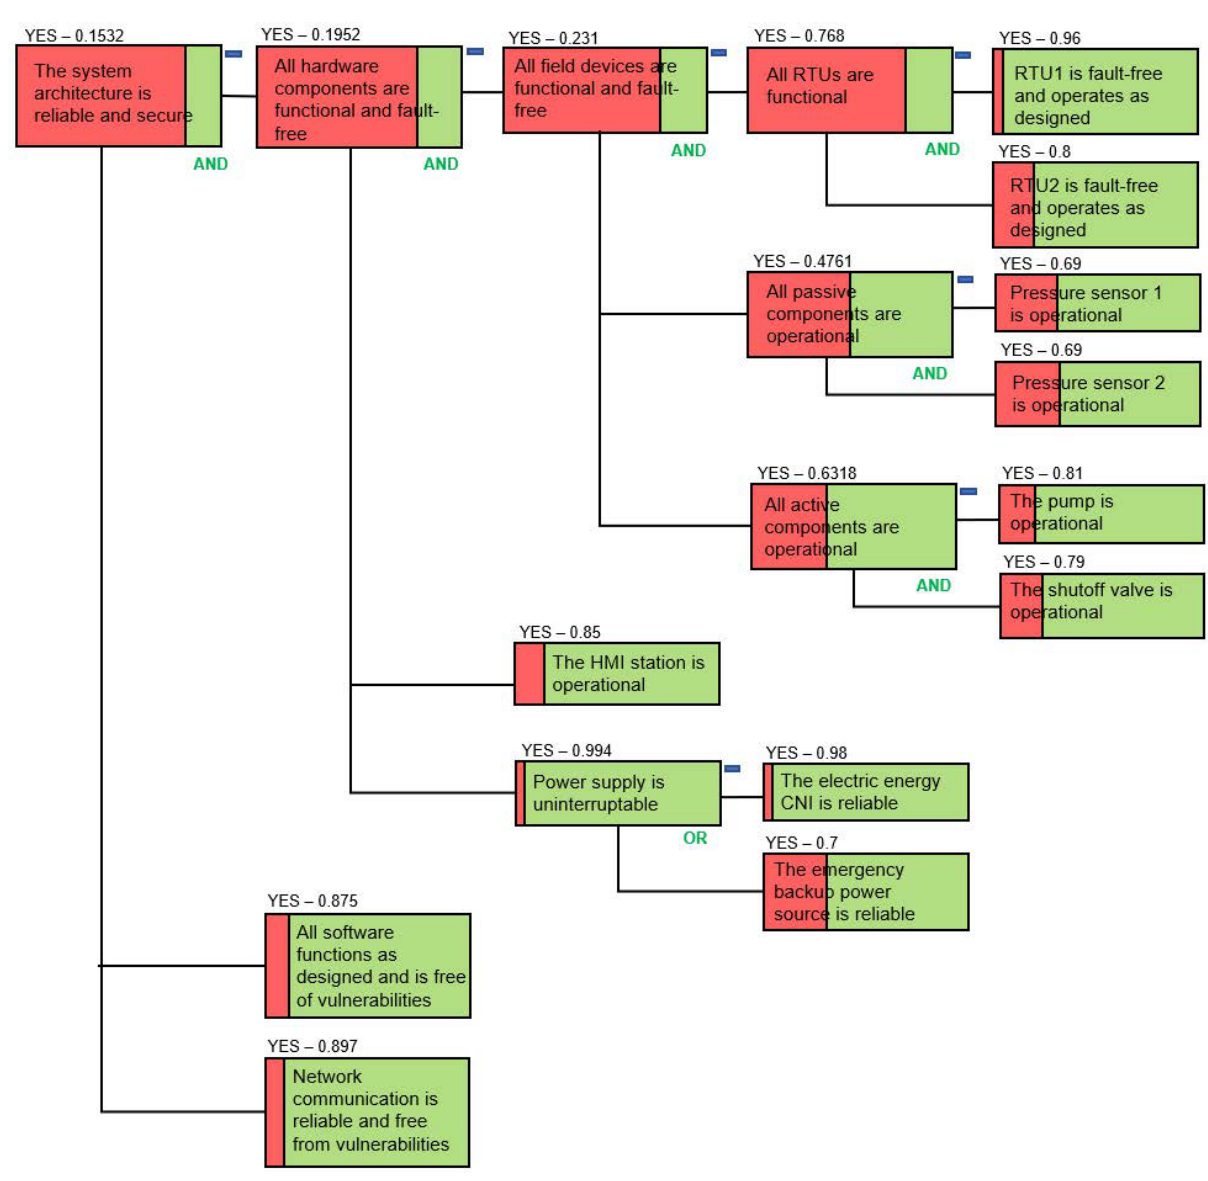
Figure 6. Dependencies of the Paragon System Architecture